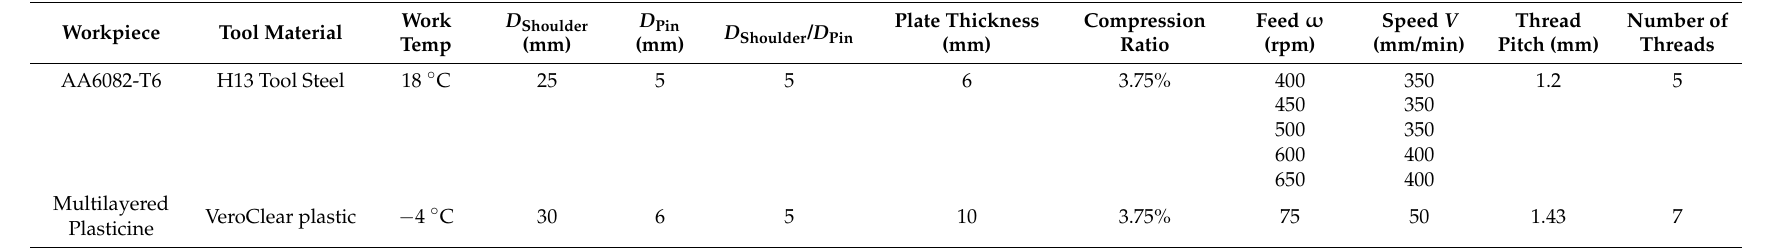
Table 1. The parameters of the welding process for the plasticine and aluminium